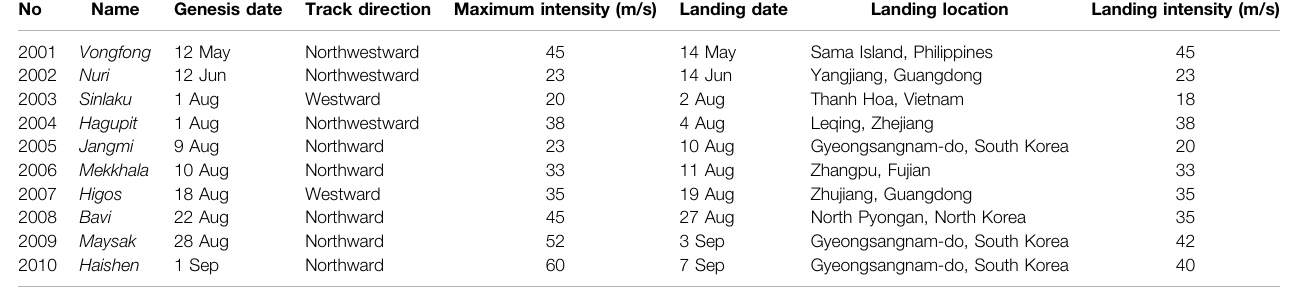
TABLE 1 | Information of TC geneses and landfall over WNP in summer 2020.